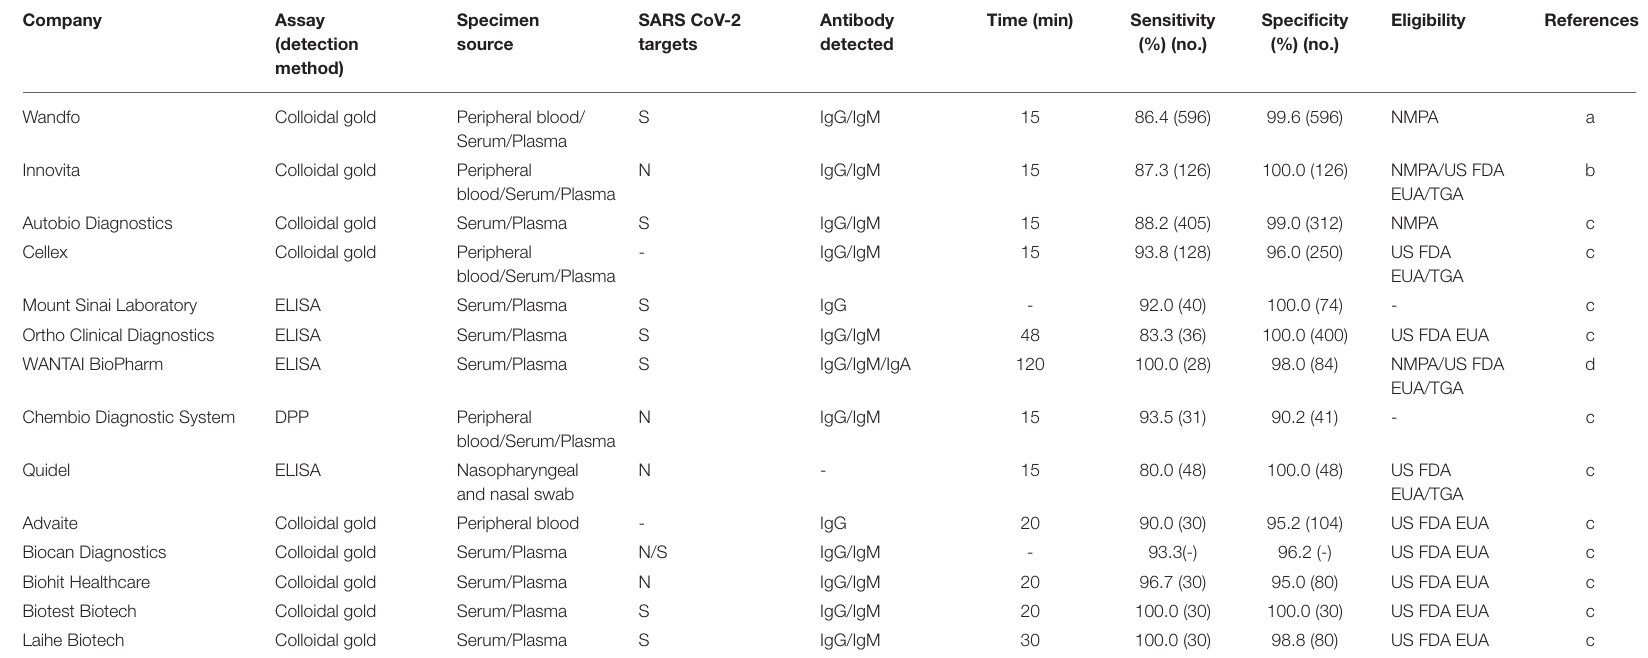
TABLE 3 | Immunoassays for